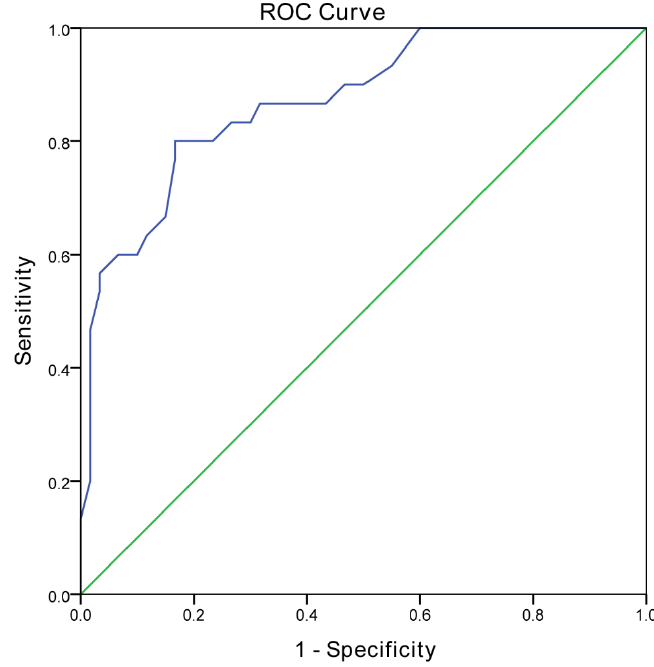
Figure 2. Receiver operating characteristic curve for the DCDQ-ES (cut-off score of 57) ( n = 90). Table 4. Predictive values and Youden’s index of the 5th and the 15th percentiles ( n = 90).